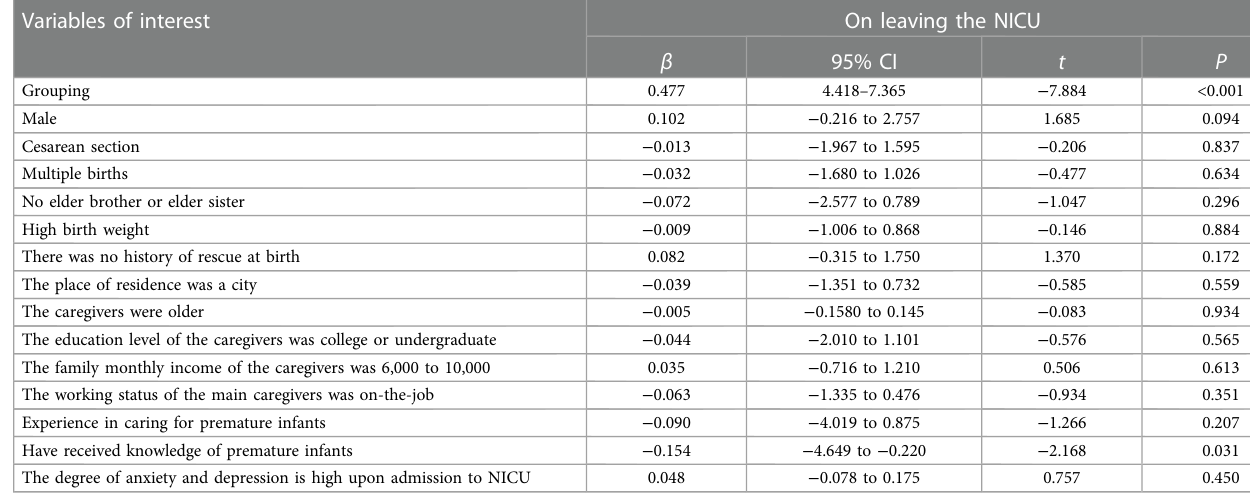
TABLE 6 Regression analysis of anxiety and depression in primary caregivers of premature infants at discharge from